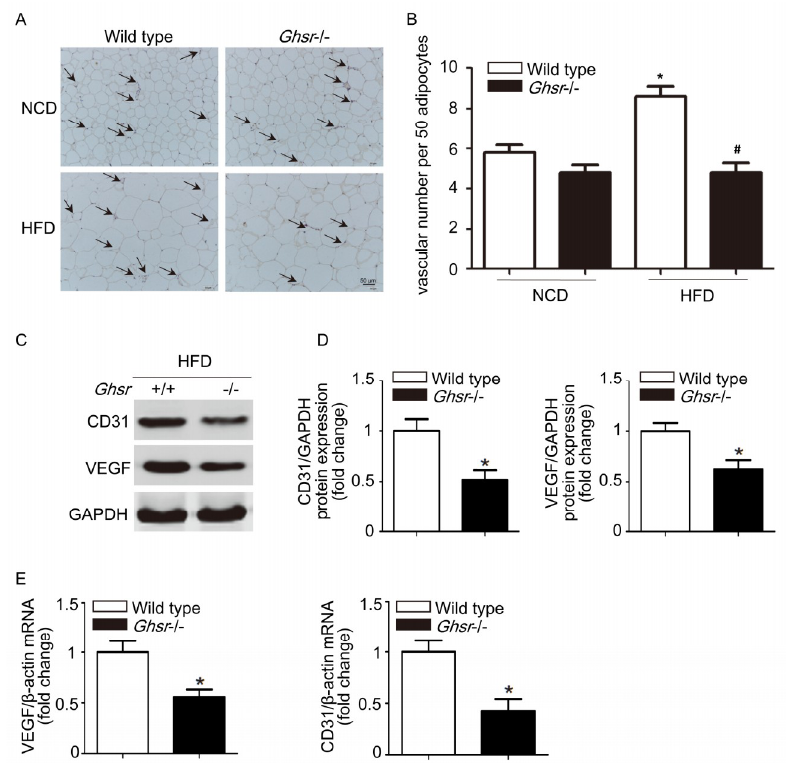
Figure 2. Blood vessels in adipose tissue of Ghsr − / − mice and wild type mice. Wild type or Ghsr1 − / − mice were fed with either NCD or 45% HFD for 12 weeks. ( A , B ) Epididymal adipose tissues from wild type mice or Ghsr − / − mice were selected and stained with anti-vWF. Results are representative images from seven different animals. The arrows indicate positive staining. Microvessels are counted and averaged in 50 tissues sections. Magnification, × 100. Data are expressed as mean ± SD, * denotes p < 0.05 compared with wild type mice fed with NCD, # denotes p < 0.05 as compared with wild type mice fed with HFD. ( C , D ) The protein level of CD31, VEGF, or GAPDH was determined by western blotting analysis. ( E ) qRT-PCR analysis of the mRNA level of EC markers. Data are expressed as mean ± SD, * denotes p <